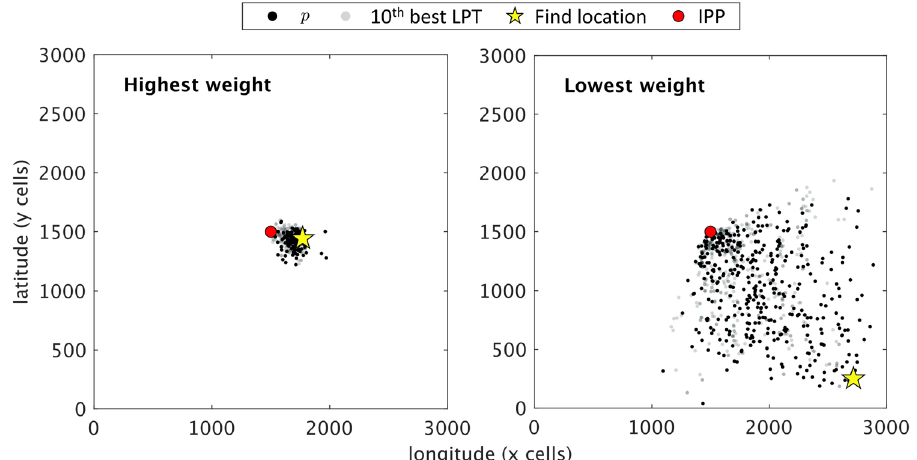
Figure 5. Examples of simulation results for two incidents. The highest (left) and lowest (right) weighted incidents with the trajectory closest points shown for p (black dots) and the tenth best LPT (grey dots) along with the IPP (red circle) and find location (yellow star).